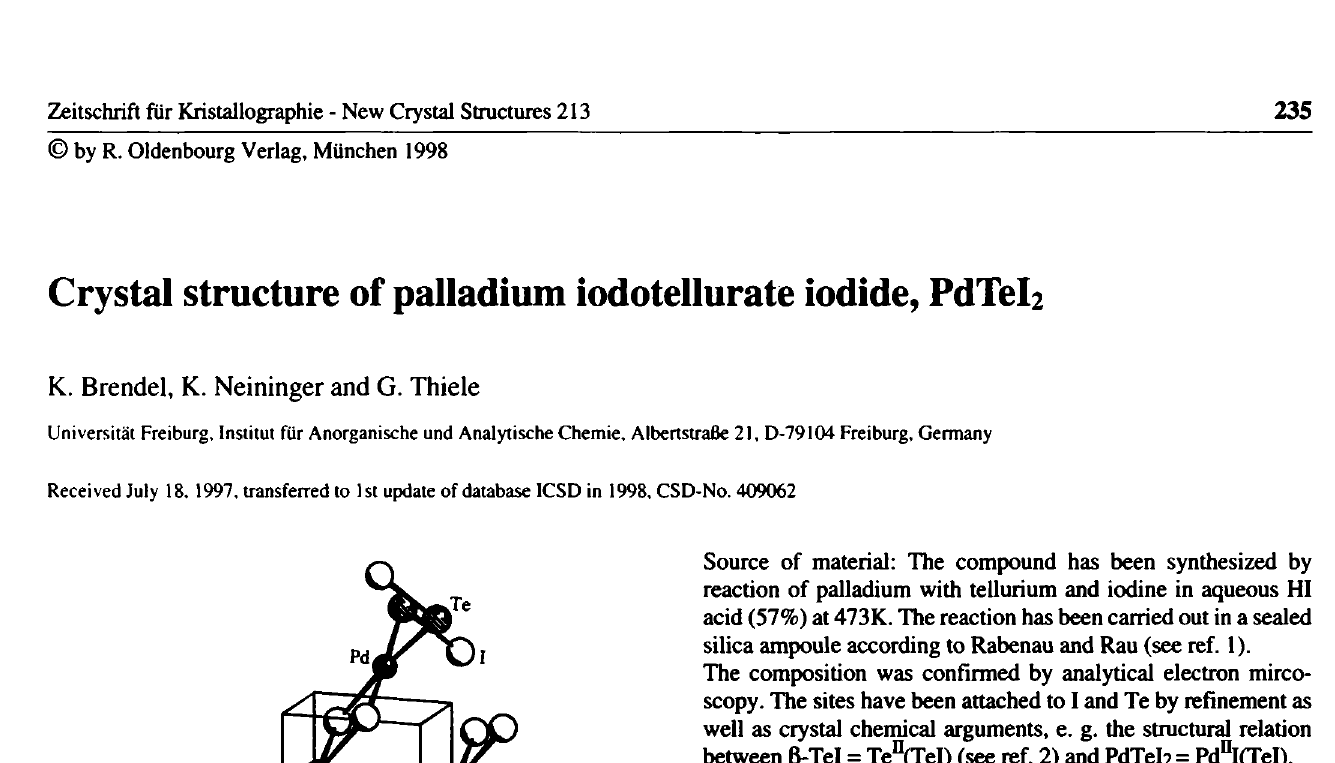
Table 1. Parameters used for the X-ray data collection Crystal: